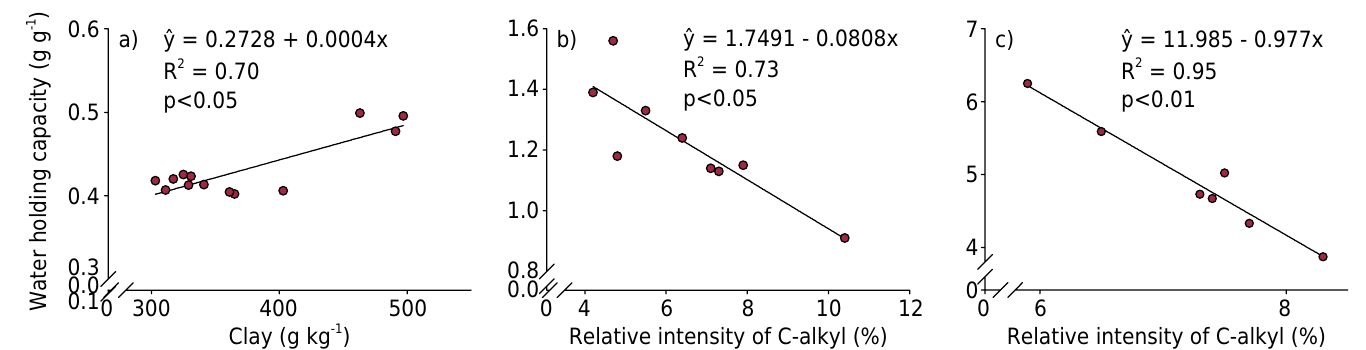
Figure 6. Linear regressions between water holding capacity and a) clay content in OX, b) relative intensity of C-alkyl in FH, c) relative intensity of C-alkyl in